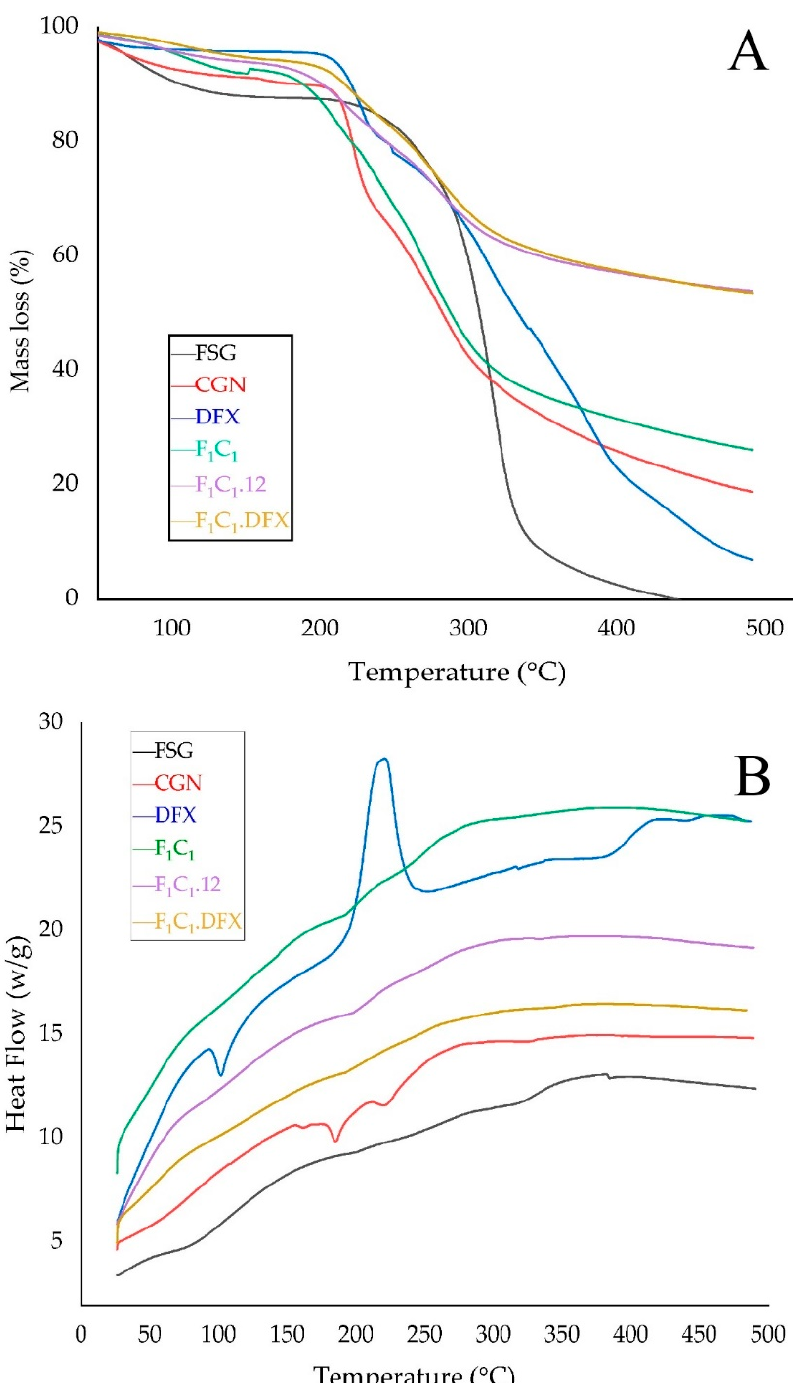
Figure 6. ( A ) TGA thermograms and ( B ) DSC thermograms of FSG, CGN, pure DFX, F 1 C 1 , F 1 C 1 .12, and F 1 C 1 .DFX.